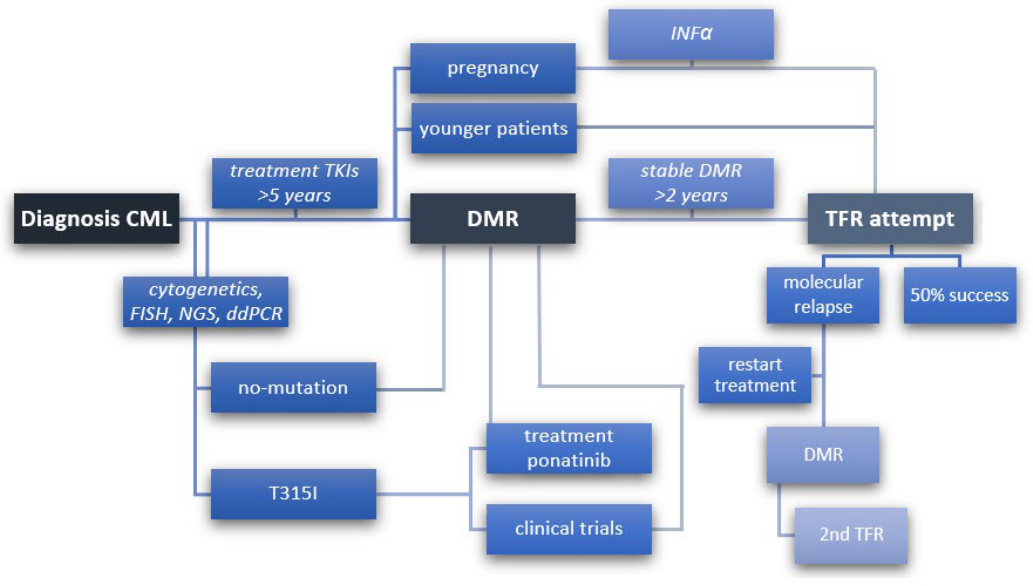
Figure 1. Steps to follow to achieve TFR from diagnosis of CML, detection of individual mutations, treatment of TKI to stable deep molecular remission (DMR), and then discontinuation of treatment (TFR) with 50% success or molecular relapse, prompting re-initiation of treatment to re-attain DMR and eventually make a second attempt to discontinuation treatment (2nd TFR). A scheme to include younger patients with low- to medium-risk disease and women who wish to become pregnant for whom TFR has a high priority .